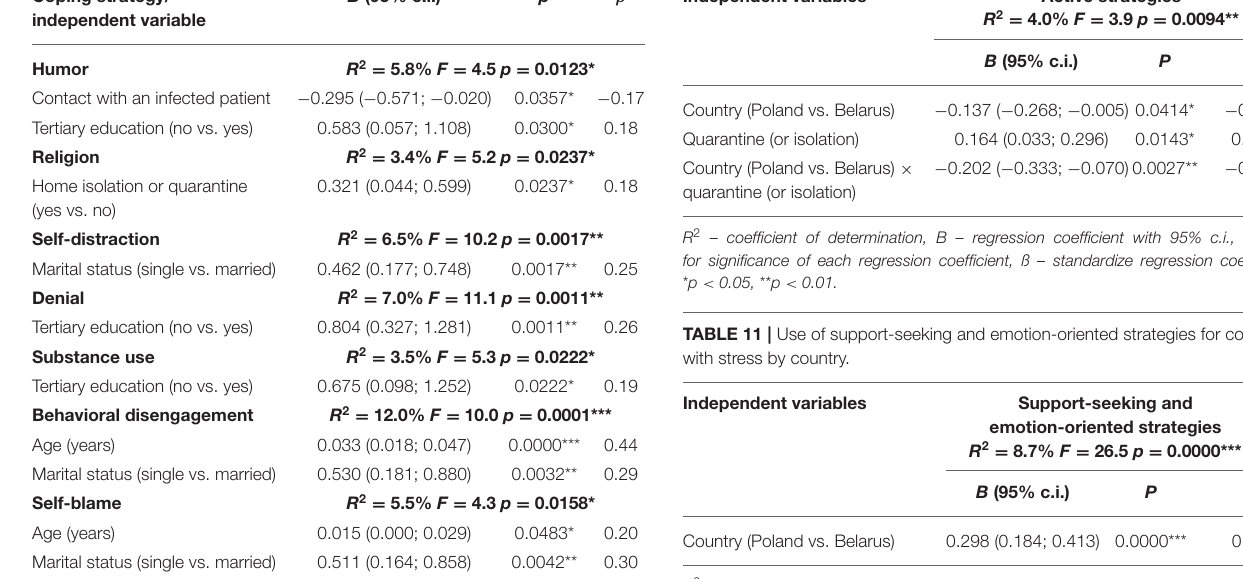
TABLE 9 | Coping strategies according to MiniCOPE among nurses in Poland, according to COVID-19 pandemic elements and demographic factors. Coping strategy/ independent variable